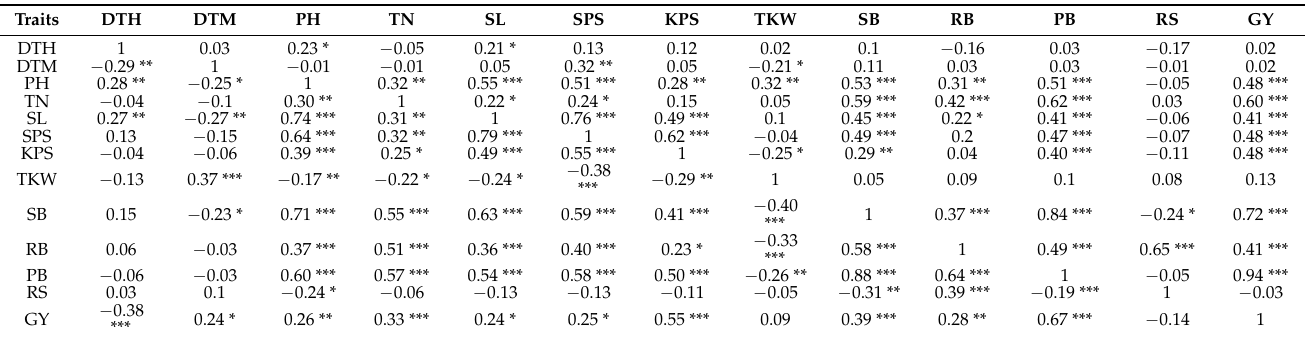
Table 3. Pearson’s correlation coefficients and significance tests for yield components and root attributes of 10 bread wheat parental lines and 90 F 2 progenies under drought-stressed (lower diagonal values) and non-stressed (upper diagonal values) conditions at two sites.